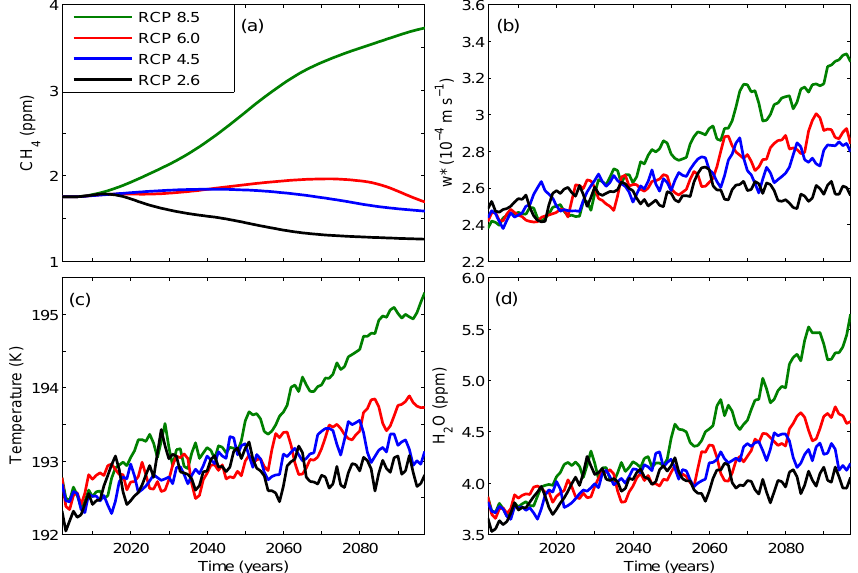
Figure 8. Same as Fig. 4 but showing drivers of SWV change in the RCPs. For clarity, the time series in (b) – (d) have been smoothed with a 5 year running mean.